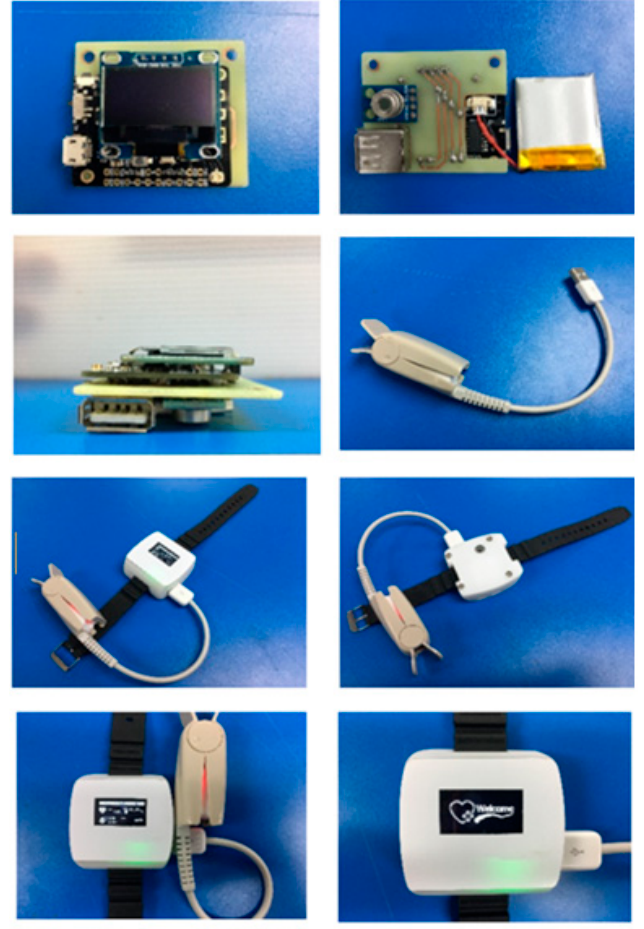
Figure 8. Ready to use sensor devices, MCU and a display